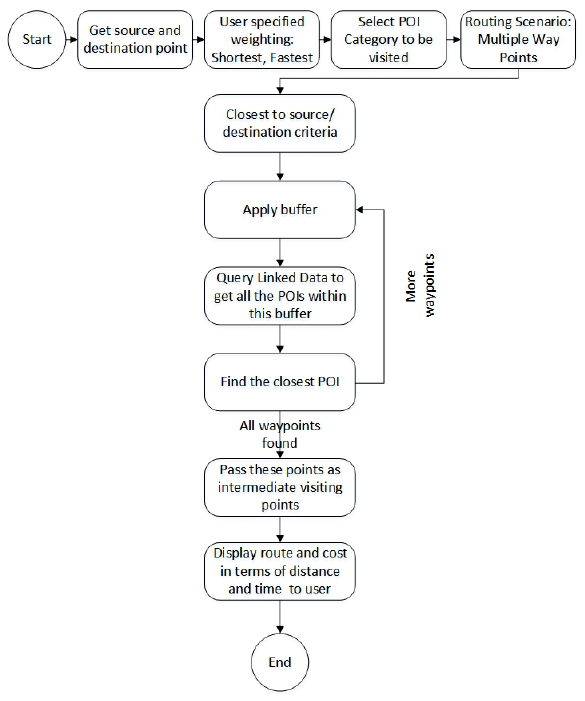
Figure 3. Routing scenario